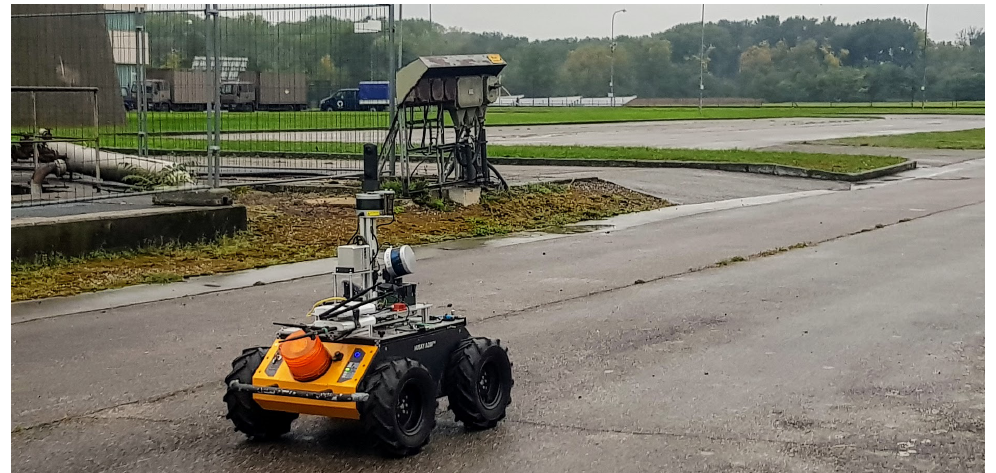
Figure 8. Robotic platform equipped with multiple mapping systems. This robot was used for the evaluation of the proposed contribution. The robot provided two 3D data streams for further